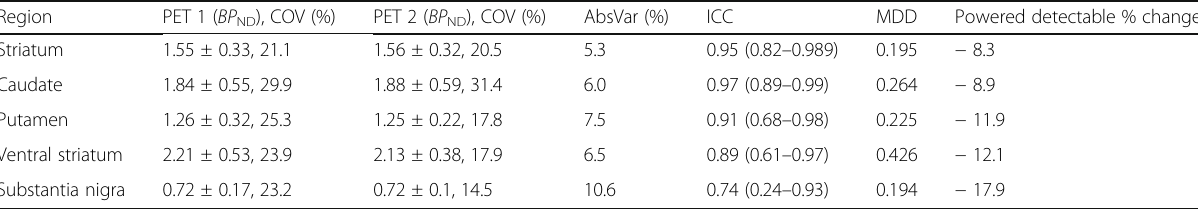
Table 3 Test-retest metrics of [ 18 F]FE-PE2I PET measurements ( n = 9) Region PET 1 ( BP ND ), COV (%)